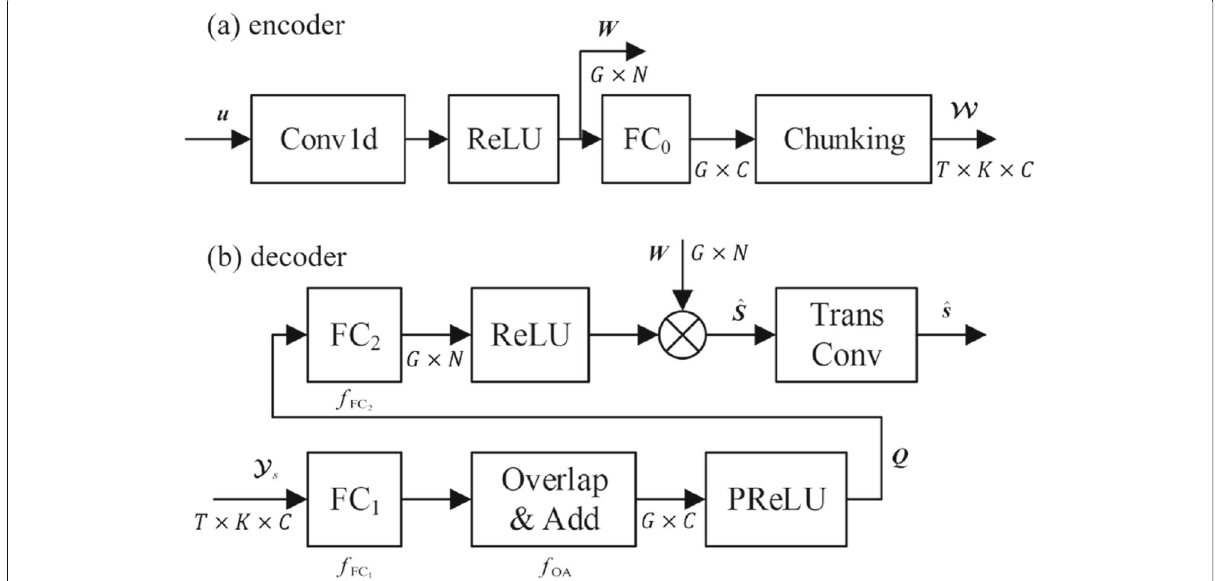
Fig. 3 The structure of the encoder and the decoder in the time-domain